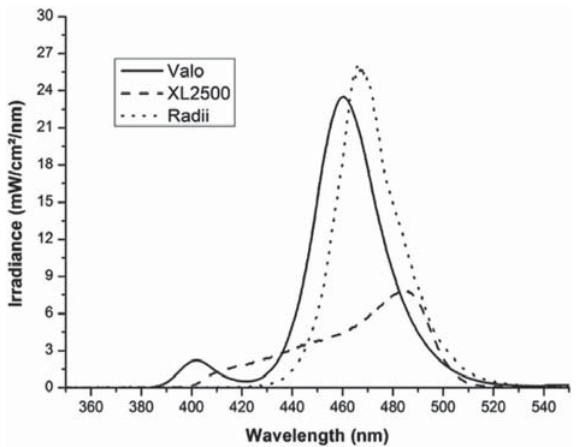
Figure 2- Absolute absorbance x wavelength (nm) for each